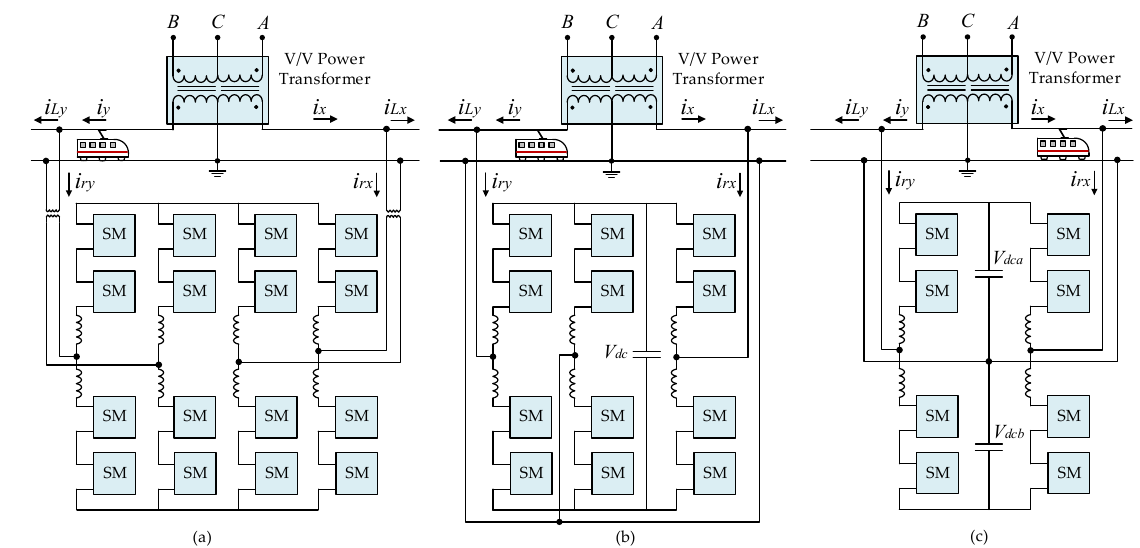
Figure 2. Rail power conditioner (RPC) topologies based on an AC/DC/AC modular multilevel converter (MMC) and